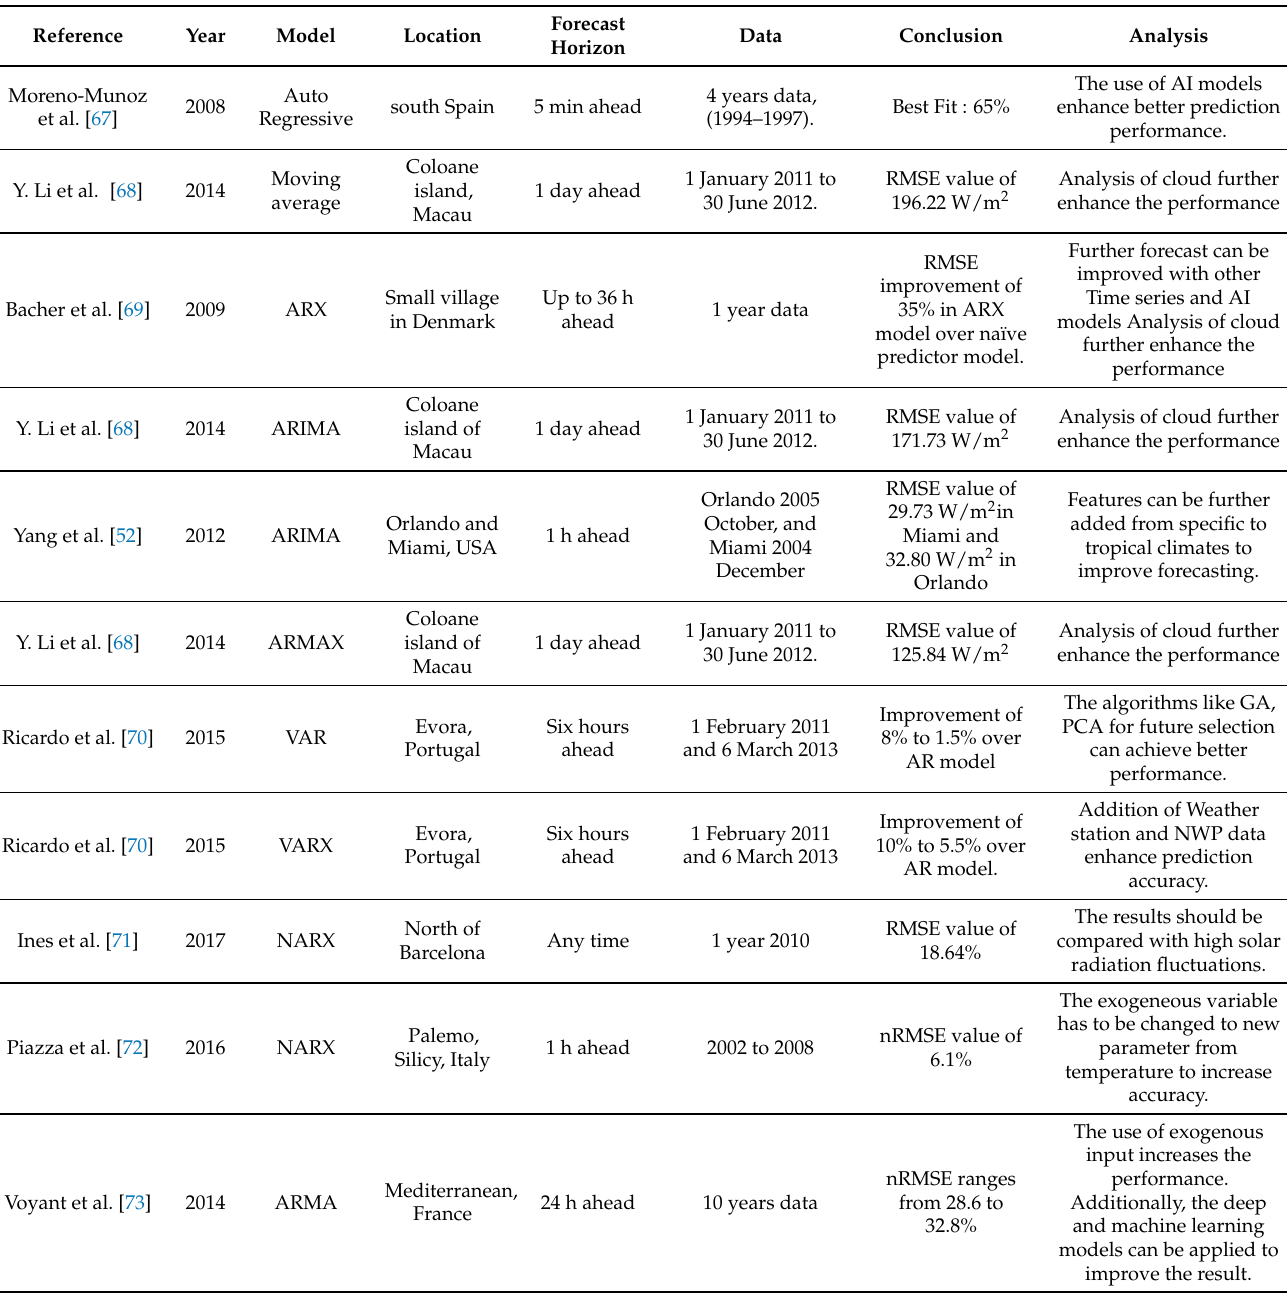
Table 5. The operational analysis of ARMA and ARIMA models with stationary dataset is described in Figure 6 by flowchart representation. Table 5. Summary of time series